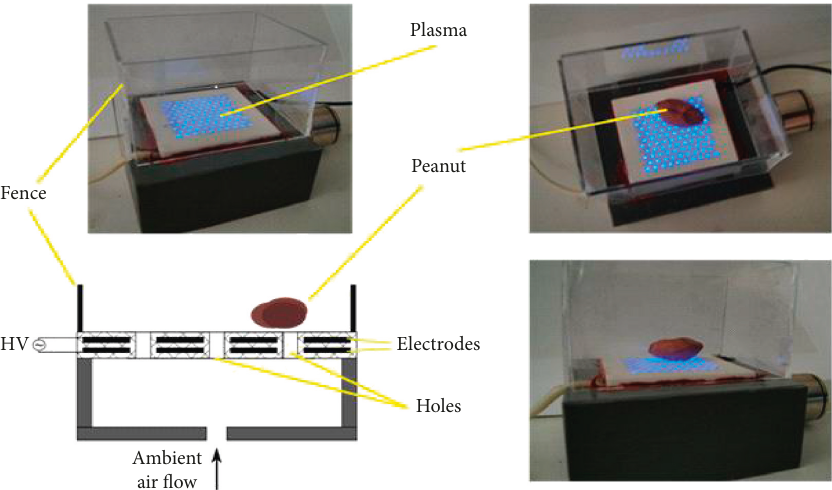
Figure 1: Multihollow surface DBD electrode